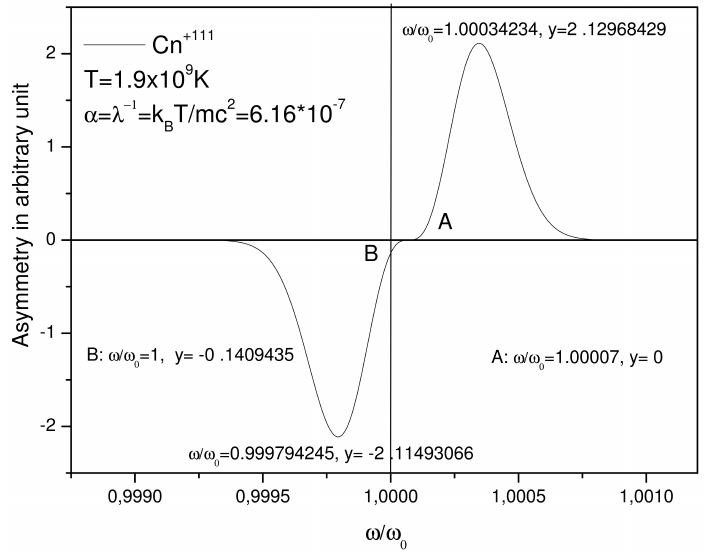
Figure 3. Asymmetry as defined by Formula (20) for Cn + 111 at T = 1.9 × 10 9 K.